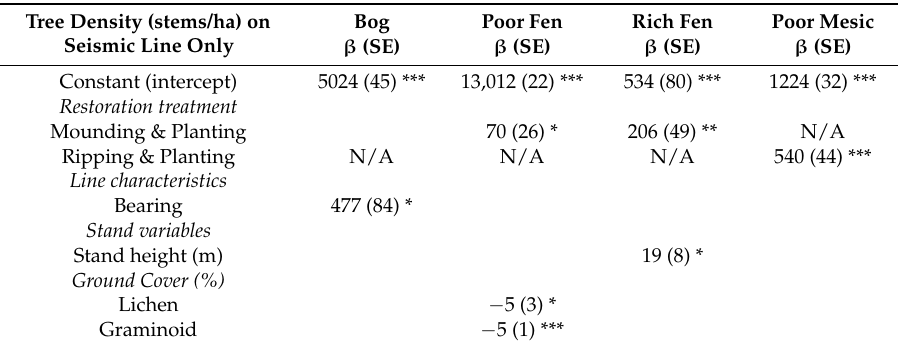
Table 3. Linear regression model parameters (coefficient, β ; and standard error, SE) relating regeneration density (log 10 transformed) of all tree species found on seismic lines to restoration treatment, line characteristics, stand variables, and percent ground cover. *** p < 0.001, ** p < 0.01, * p < 0.05. RMSE is root mean squared